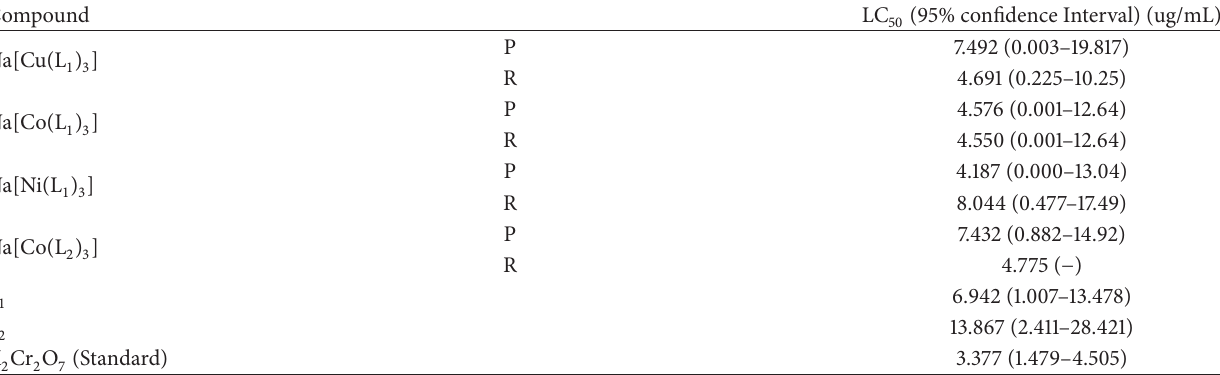
Table 4: Cytotoxic activity of the parent and resolved